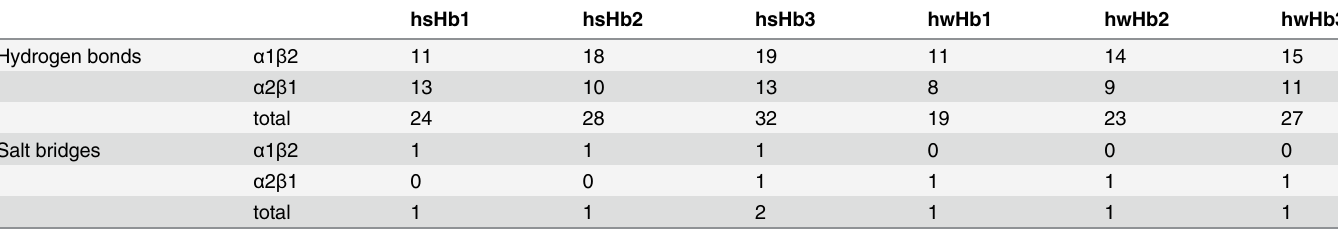
Table 6. Hydrogen bonds and salt bridges at α 1 β 2 and α 2 β 1 interfaces of the six Hb models. hsHb1 hsHb2 hsHb3 hwHb3